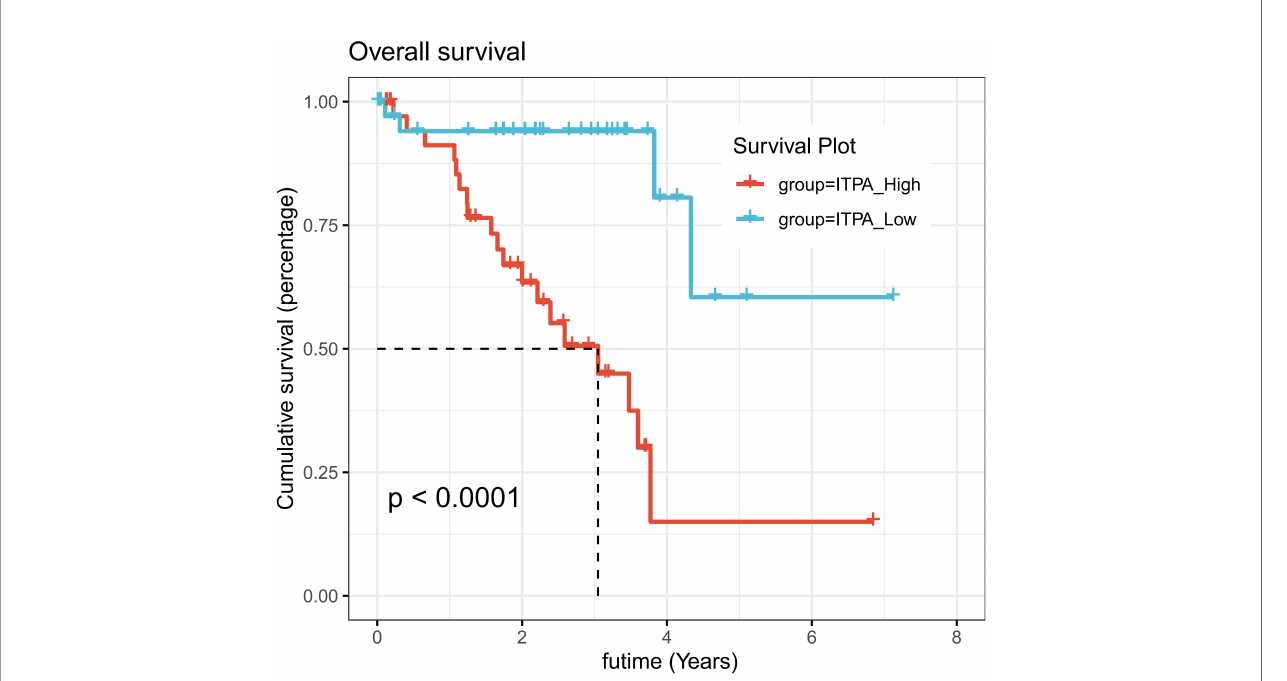
FIGURE 7 | Survival analysis of ITPA in UVM. UVM patients with high expression of ITPA had signi fi cantly worse prognosis than patients with low expression of ITPA (P <